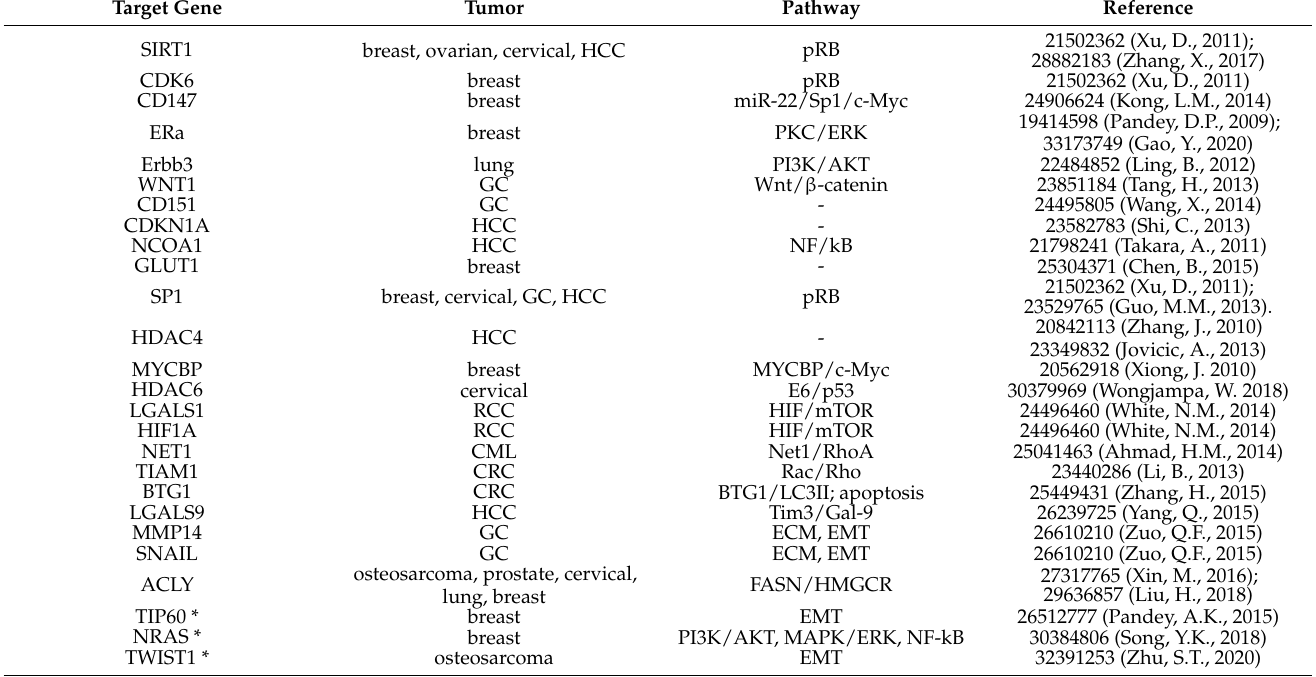
Figure 1. Schematic representation of miR-22 genomic locus on chromosome 17. Table 1. Validated miR-22 target genes in